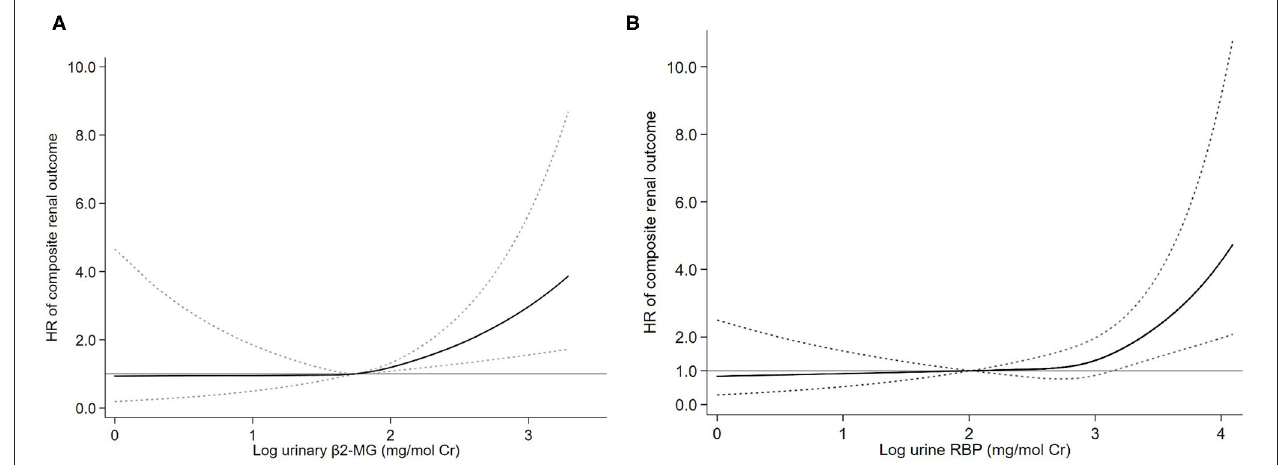
FIGURE 2 | Association of log-transformed urinary β 2-microglobulin ( β 2-MG) (A) and log-transformed urinary retinol-binding protein (RBP) (B) levels with the composite renal outcome. Three knots at the 25th, 50th, and 75th percentiles were used to model restricted cubic splines. Solid lines are multivariable adjusted hazard ratios, with dashed lines showing 95% CIs for the spline model (reference: log β 2-MG 1.75 mg/mol Cr and log RBP 2.00 mg/mol Cr). Models were adjusted for age, sex, mean arterial pressure (MAP), log-transformed proteinuria, serum creatinine, and the Oxford classification (MEST-C scores).